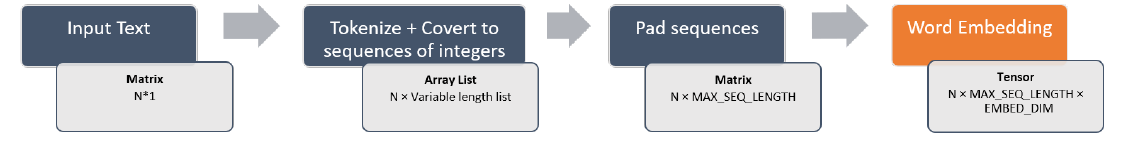
Figure 2. Word embedding